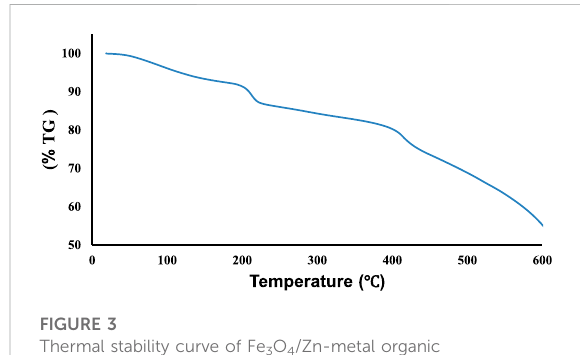
FIGURE 3 Thermal stability curve of Fe 3 O 4 /Zn-metal organic framework magnetic nanostructures.